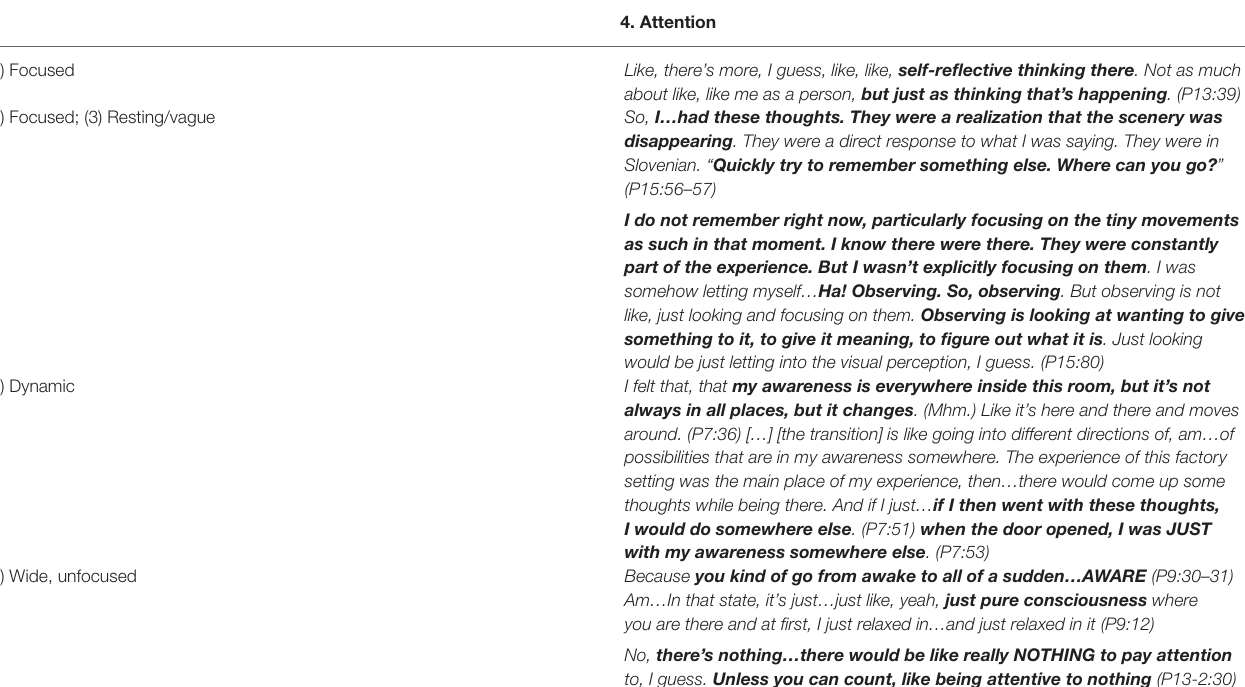
TABLE 9 | Illustrative examples of each of the types of “ Attention ” isolated from the phenomenological analysis.